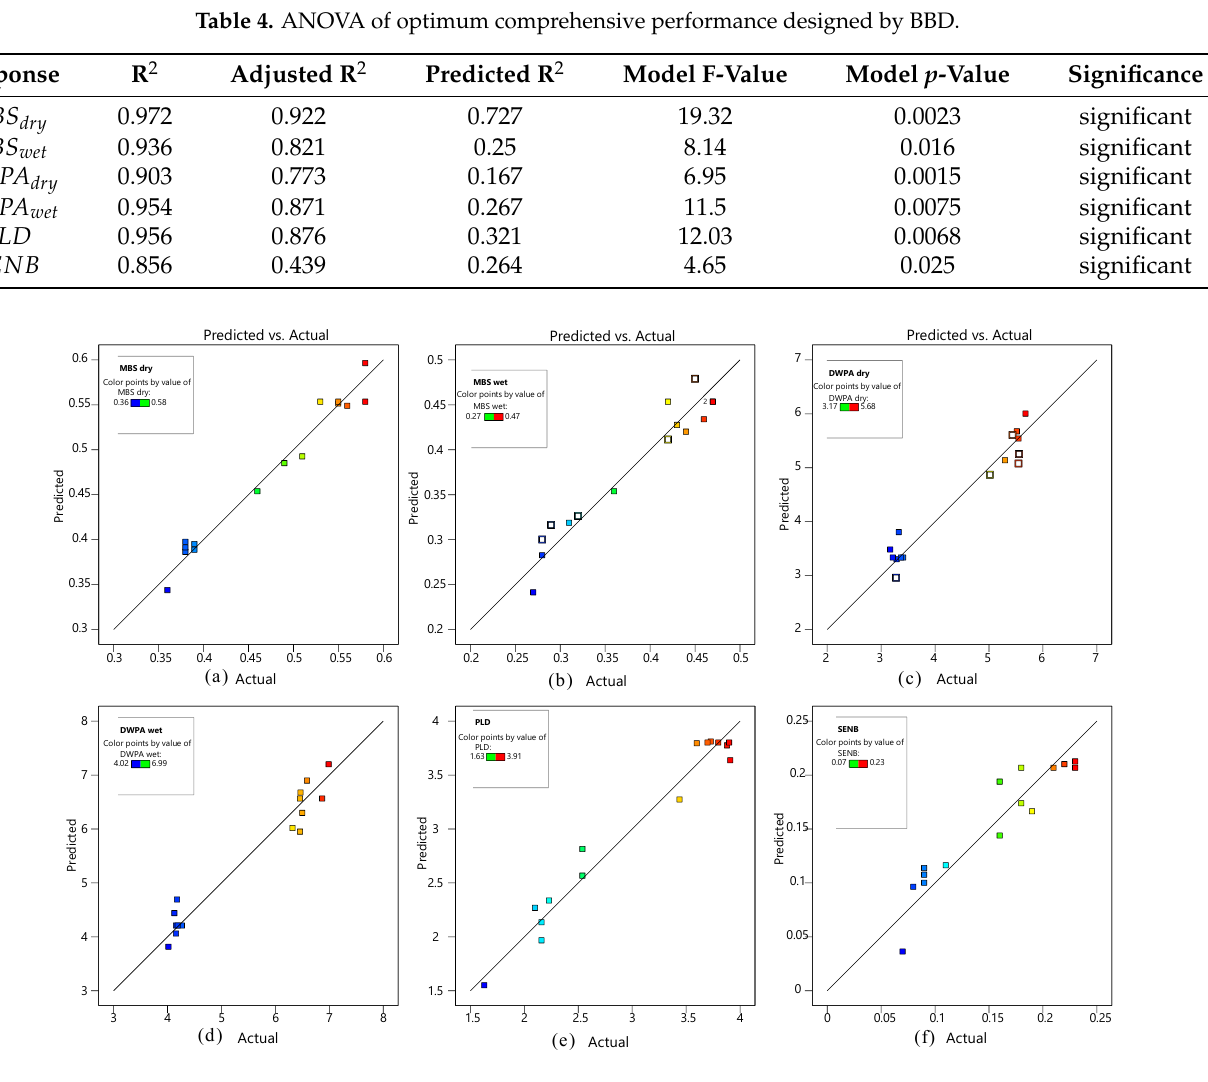
Figure 5. The linear simulation of predicted versus actual values: ( a ) MBS dry , ( b ) MBS wet , ( c ) DWPA dry , ( d ) DWPA wet , ( e ) PLD, and ( f )